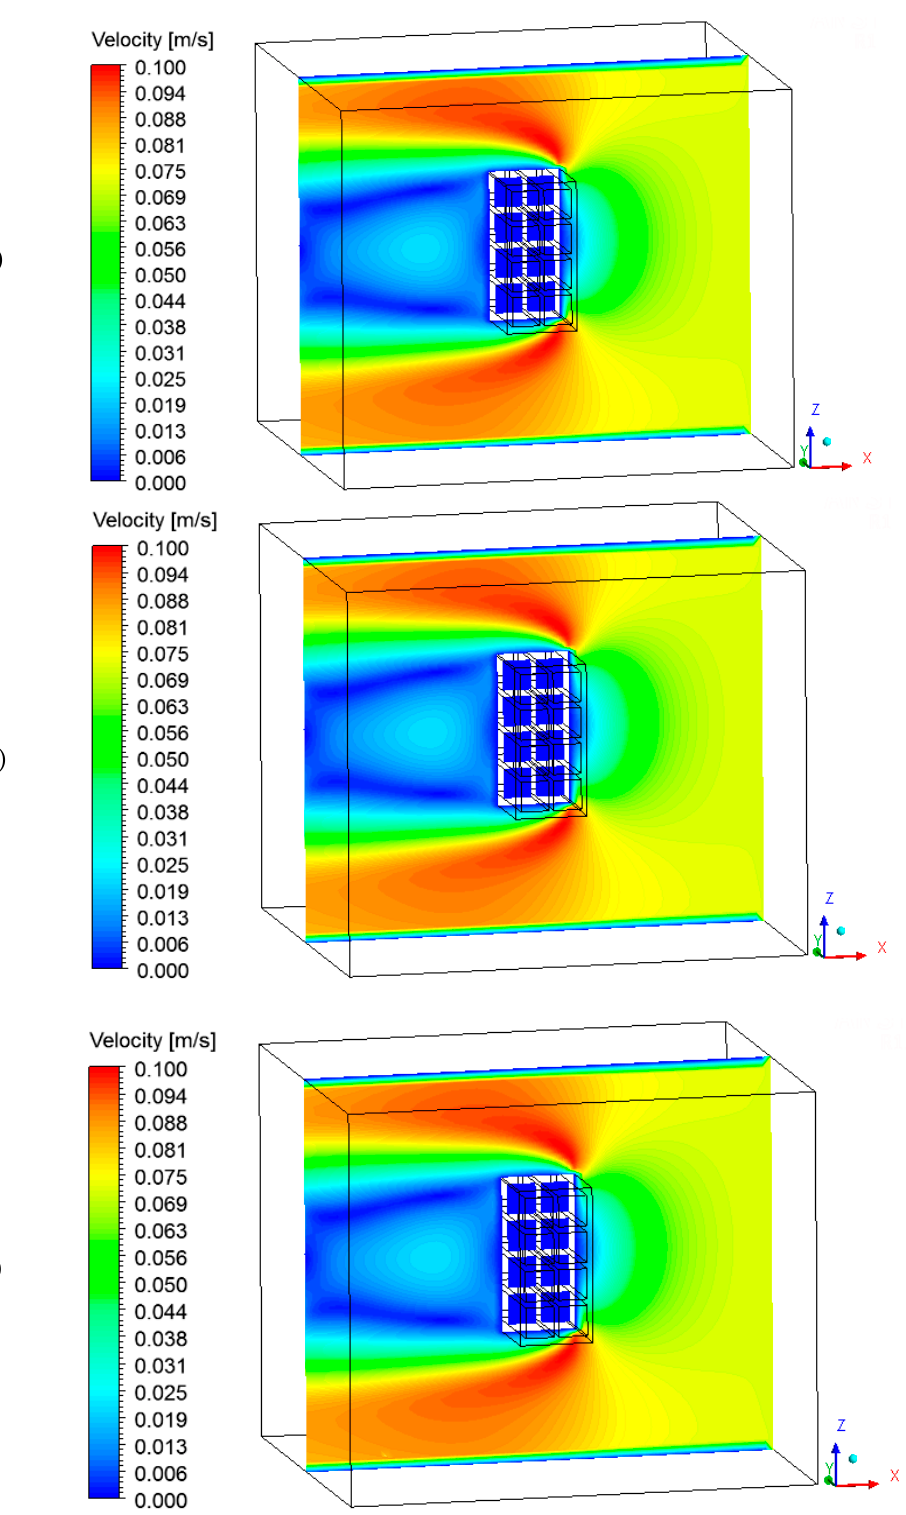
Figure 15. Velocity field of the air in the plane XZ (Y = 0.1 m) at di ff erent moments of drying: ( a ) 10 min, ( b ) 60 min, and ( c ) 950 min.